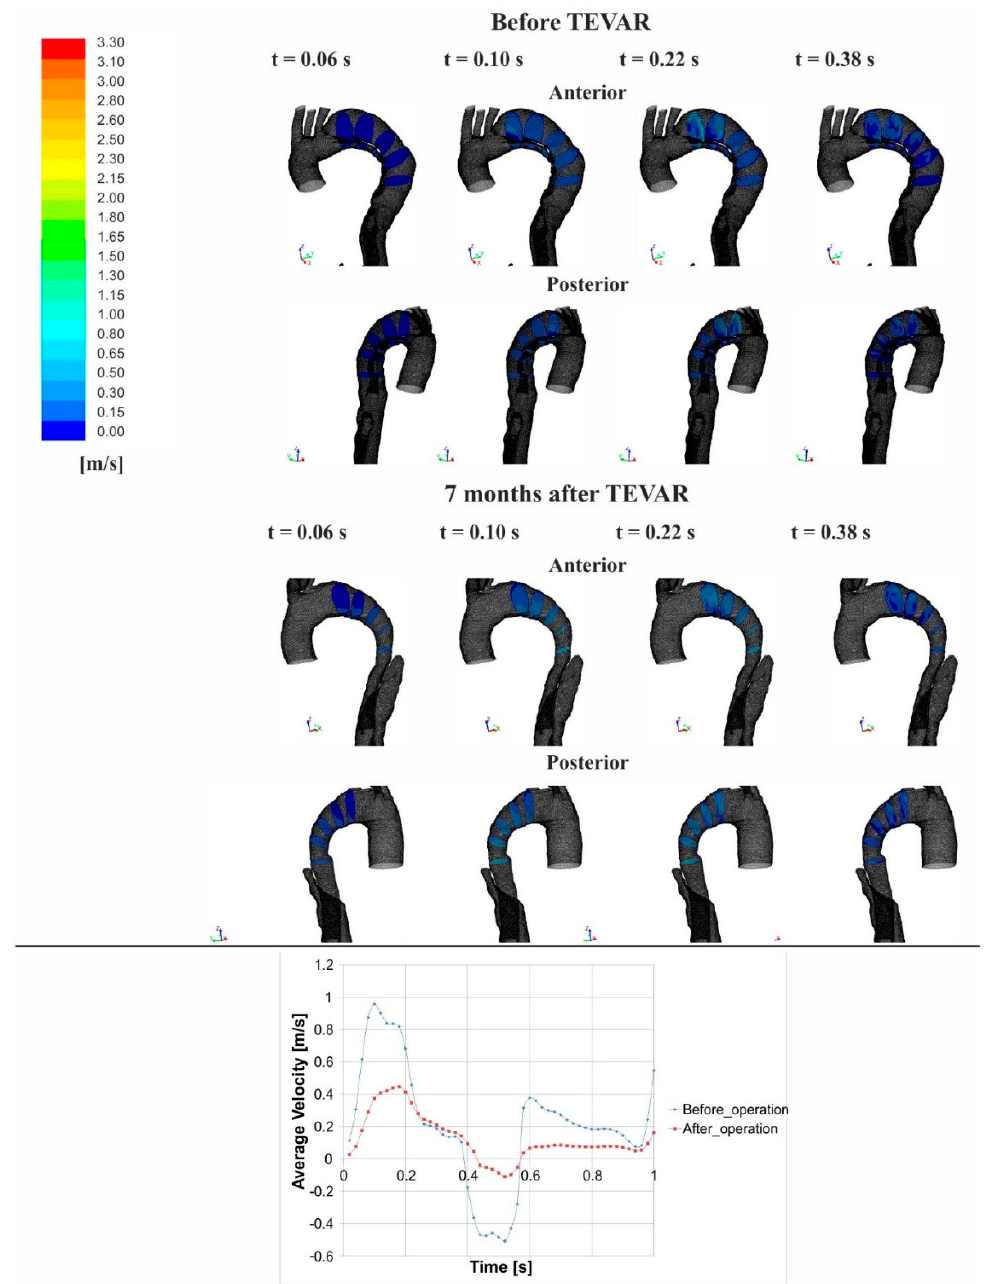
Figure 2. Changes in blood velocity contours of the aortic arch for a representative patient. ( top ) velocity contour distribution in the aortic arch for representative time points before and 7 months after TEVAR; ( bottom ) the average velocity changes for one cardiac cycle. Changes in velocity contours were presented for the anterior and posterior position in the aortic arch. Numerical simulations were calculated using ANSYS FLUENT software.